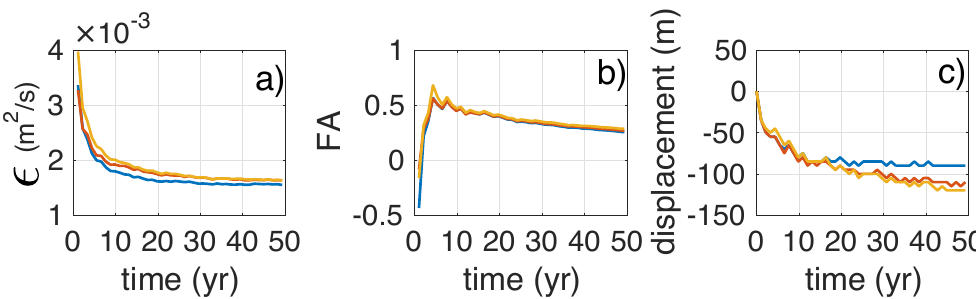
Figure A2. The 50-year evolution of: ( a ) diffusivity; ( b ) feeding asymmetry; and ( c ) displacement for the Zandmotor (blue lines), simplified Zandmotor (red lines) and synthetic mega-nourishment (yellow lines)